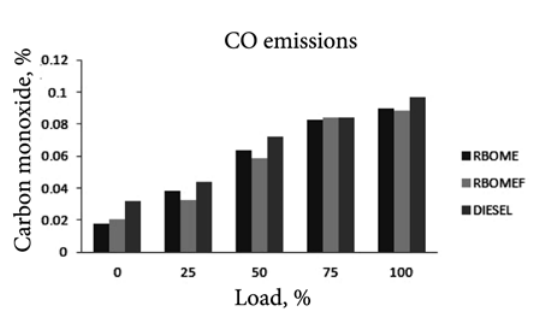
Fig. 3. Carbon monoxide emission with respect to